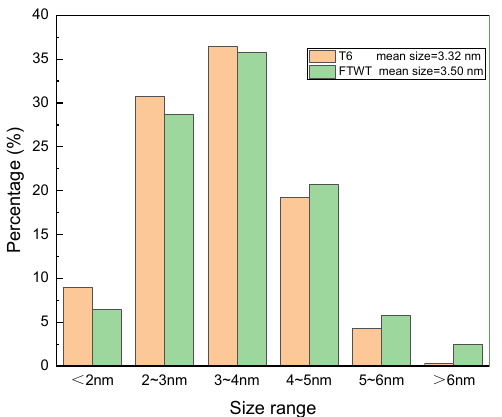
Figure 9. The distribution for the sizes of precipitated phases under different processes. Based on the dispersion strengthening mechanism, the influence of precipitation charac- teristics on the tensile strength of aluminum alloy can be described as Function (1) [20,22]: